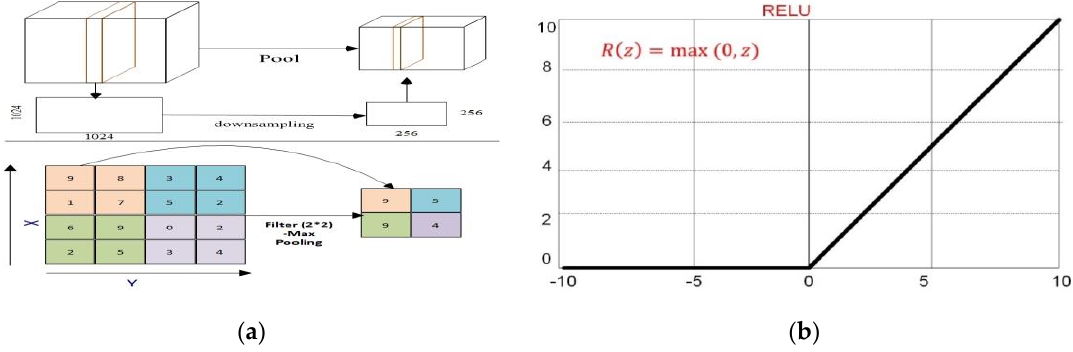
Figure 9. ( a ) Representation of max pooling layer and ( b ) rectified linear unit (ReLU) activation function.